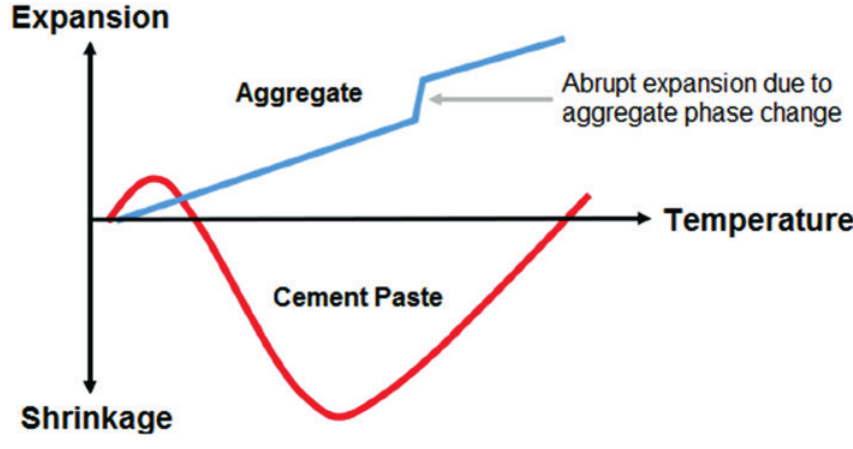
Thermal incompatibility between aggregate and hydrated cement paste (adapted